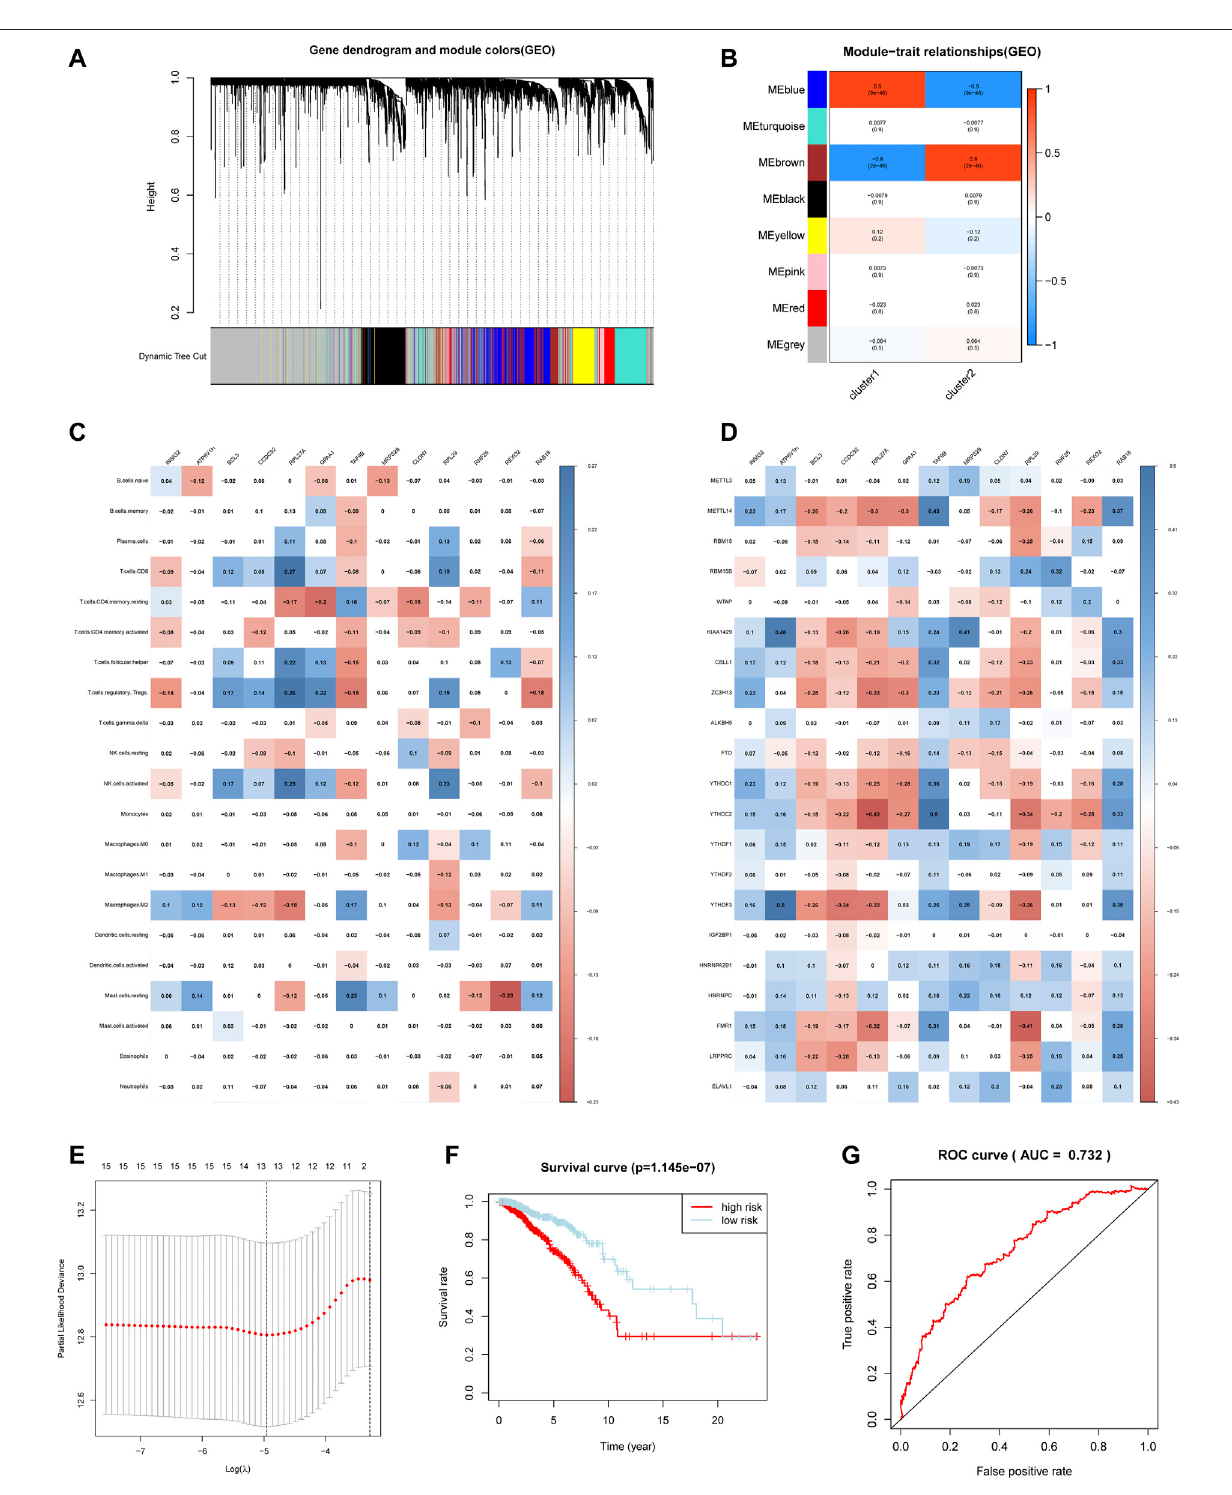
Frontiers in Genetics |